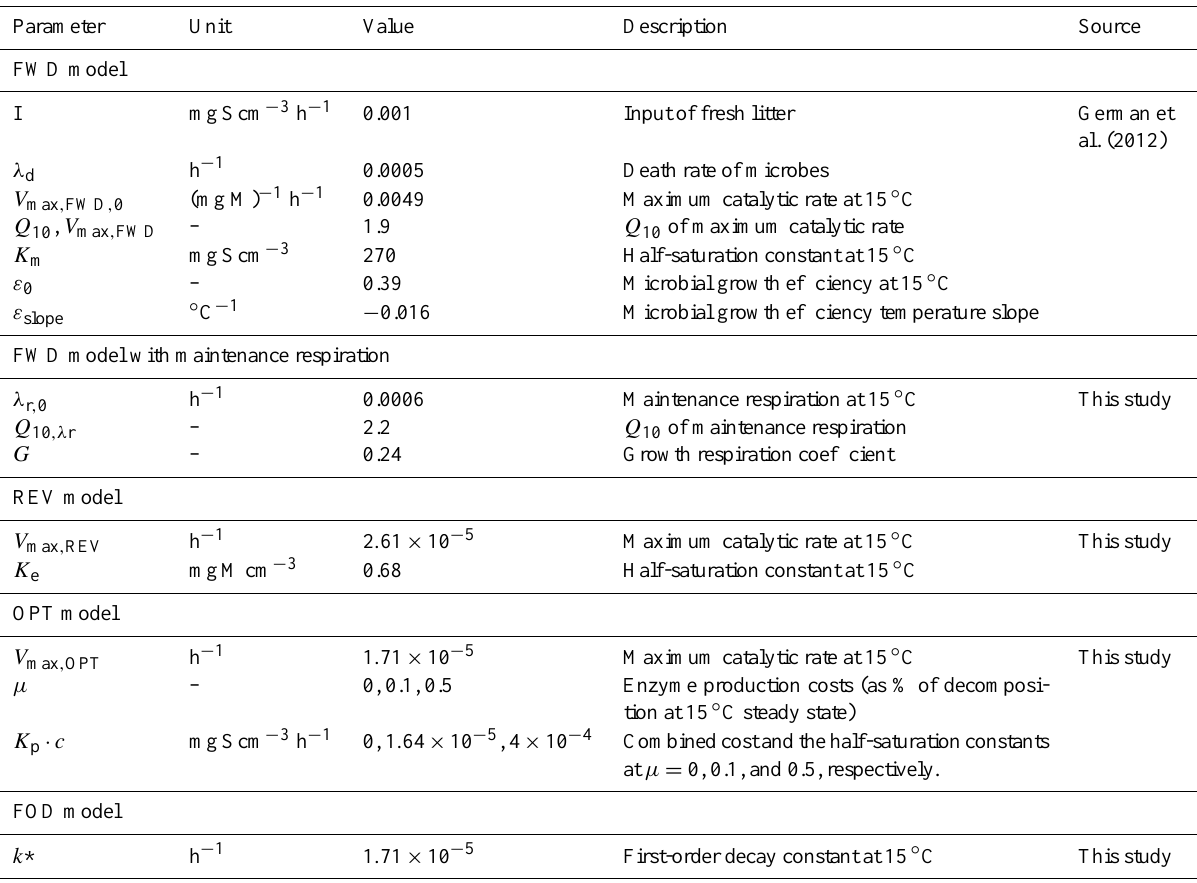
Table 3. Parameters used in microbial decomposition models. (In the model list, we provide only those parameters where modifications have been